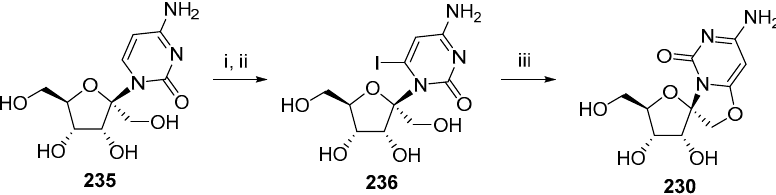
Figure 10. Polycyclic spironucleosides.